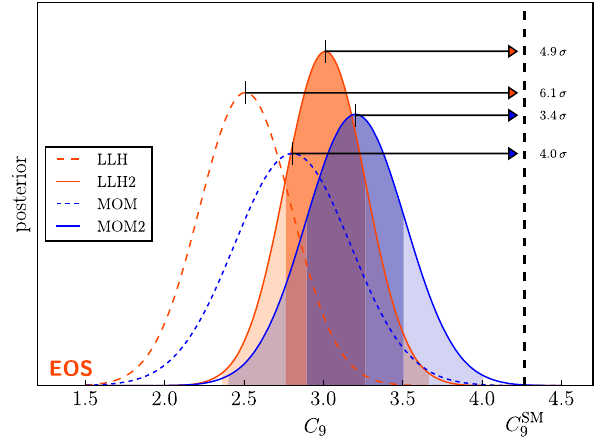
Fig. 3 Posterior distributions for C 9 from the NP fits and their respec- tive pulls. Dark and light shaded regions correspond to 68% and 99%